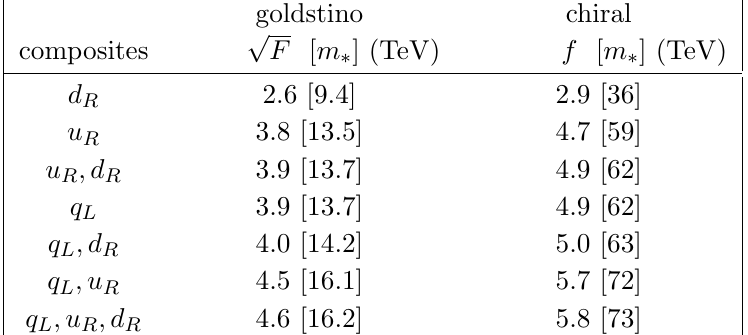
p Table 5 . 95% CL bounds on the SUSY-breaking scale F for di(cid:11)erent quark as pseudo-Goldstini scenarios (second column) and on the scale f for di(cid:11)erent cases of chiral-compositeness of quarks (third column). The respective Wilson coe(cid:14)cients are given by c ij = 1 = (2 F 2 ) for the operators in eq. (5.1) and by c (1) = 1 =f 2 for the operators O (1) = ( (cid:22) i (cid:13) (cid:22) i )( (cid:22) j (cid:13) (cid:22) j ) given in ref. [3]. The ij ij p compositeness scale in each case is given by m (cid:3) (cid:17) g (cid:3) F or m (cid:3) (cid:17) g (cid:3) f with g (cid:3) = 4 (cid:25) , their bounds reported in